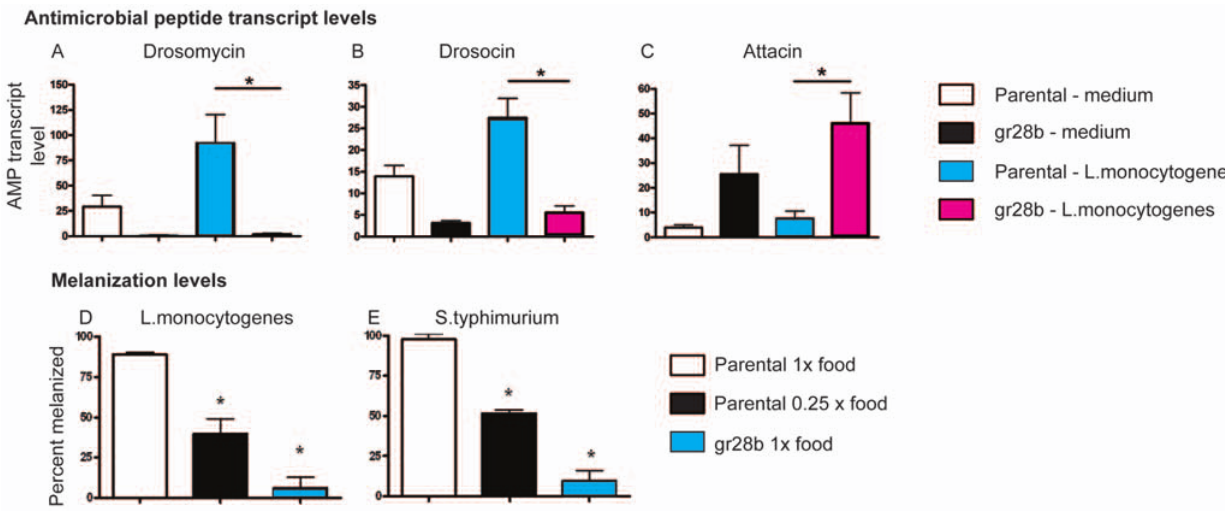
Figure 6. Effect of anorexia and diet restriction on antimicrobial peptide expression and melanization. gr28b mutants and diet restricted flies were injected with L. monocytogenes , and antimicrobial peptide transcript levels were monitored at 6 h postinfection by quantitative real-time reverse-transcription PCR. Transcript levels were recorded as the ratio of the antimicrobial peptide transcript divided by a housekeeping transcript (ribosomal protein 15a) and normalized to 1 for unmanipulated wild-type flies. (A) drosomycin; (B) drosocin; (C) attacin. Error bars report standard error of the mean. ANOVA and Tukey tests were performed for statistical analysis and asterisks indicate p , 0.05. Melanized spots were recorded in (D) L. monocytogenes and (E) S. typhimurium infections. ANOVA and Tukey test were done for statistical analysis. Asterisks represent p , 0.001.